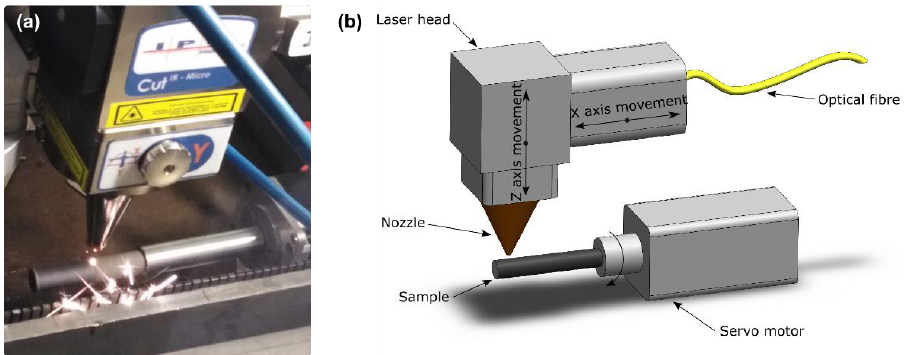
Figure 1. Experimental setup for laser finishing: ( a ) real image; ( b ) schematic view.